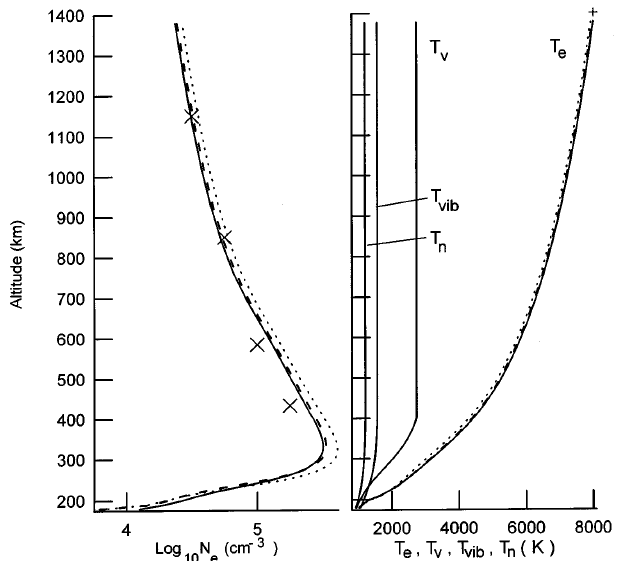
Fig. 6. Altitude profiles of the modelled ( lines ) electron densities ( left panel ) and temperatures ( right panel ) in the SAR arc region at 05:51:51 UT on 4 August, 1972, in comparison with the ISIS II spacecraft measurements ( crosses ) of the electron densities and temperatures. The modelled electron densities, N e , and temperatures, T e , were obtained with e(cid:128)ects of N 2 (cid:133) v (cid:134) and O 2 (cid:133) v (cid:134) ( solid lines ) on the O (cid:135) (cid:133) 4 S (cid:134) loss rate, and when N 2 (cid:133) v (cid:134) was not included in the calculations ( dashed lines ) of this loss rate. The dotted lines give results without e(cid:128)ects of N 2 (cid:133) v (cid:134) , and O 2 (cid:133) v (cid:134) on the O (cid:135) (cid:133) 4 S (cid:134) loss rate. The right panel shows also the vibrational temperatures, T vib and T v , of O 2 and N 2 , and the neutral temperature, T n , from the IZMIRAN model in the SAR arc region at 05:51:51 UT on 4